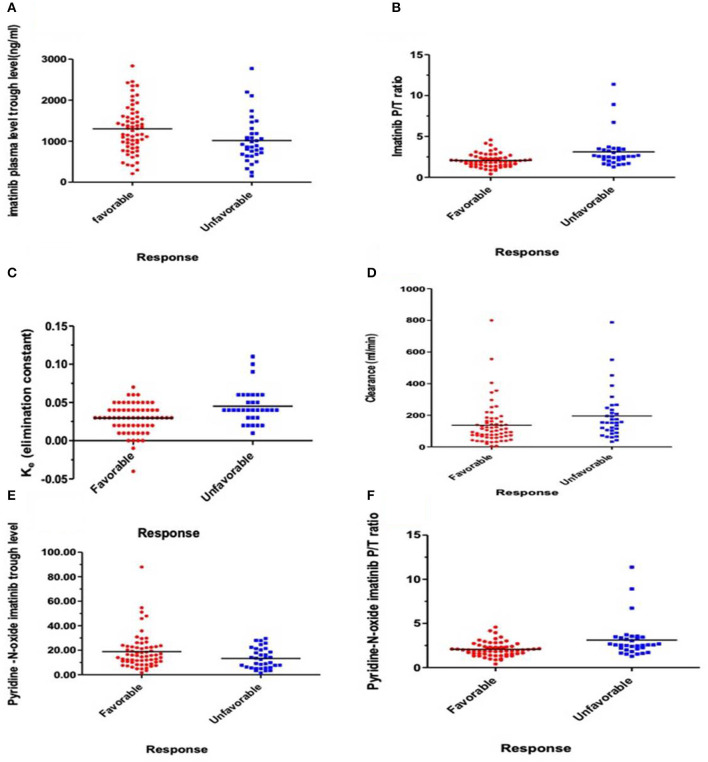
Relations express the relation between response and pharmacokinetic parameters. (A) Plasma IM trough concentration (ng/ml) (P = 0.006), (B) IM peak/trough ratio (P/T) (P = 0.001), (C) Elimination rate constant (Ke) (P = 0.001), (D) IM clearance (ml/min) (P = 0.004), (E) Plasma trough of Pyridine-N-oxide imatinib (P = 0.01), and (F) Peak/Trough ratio (P/T) Pyridine-N-oxide imatinib (P = 0.008).